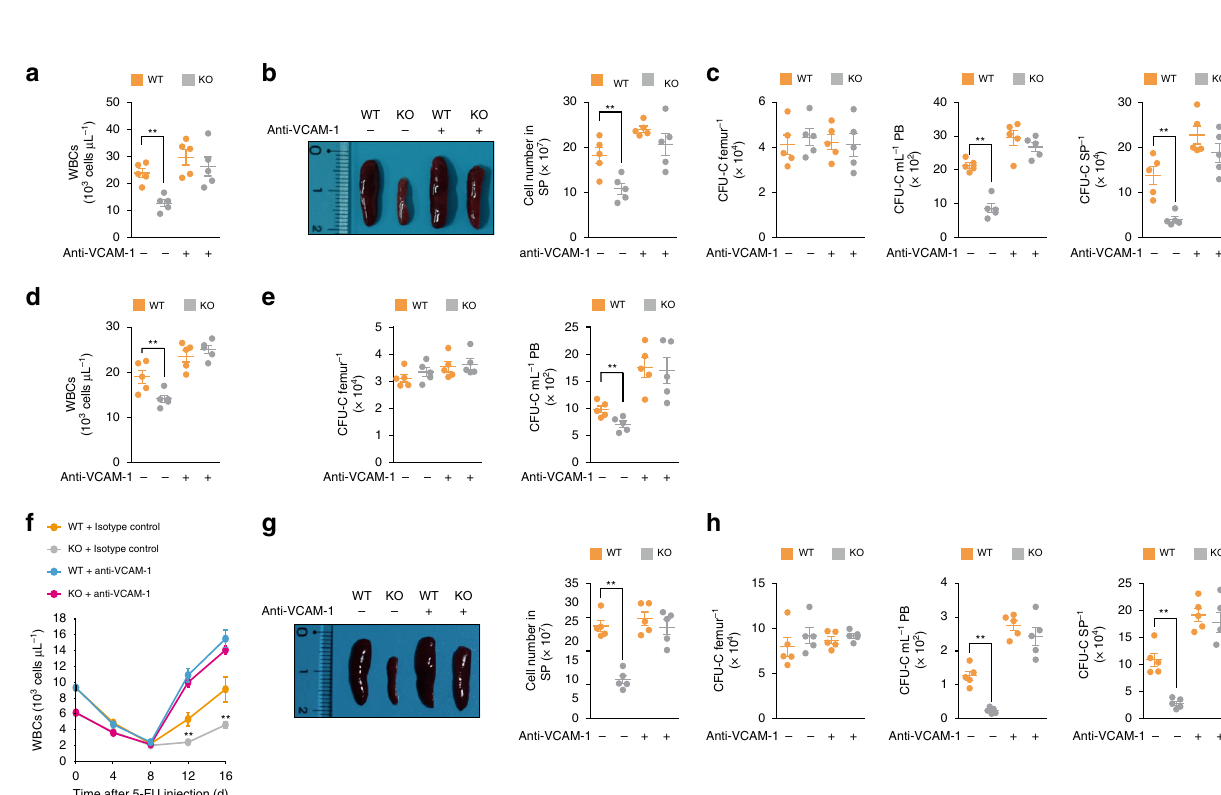
Fig. 8 Neutralizing interaction between VCAM-1 and VLA-4 reverses the defect involving regimen-induced HSPC mobilization in KO mice. a – c G-CSF- induced HSPC mobilization assays with anti-VCAM-1 Ab. n = 5 per group. a WBC counts from experimental animals until day 5 after G-CSF and Ab treatment. b Representative image of spleens (left) and absolute number of splenocytes from experimental animals on day 5 after G-CSF and Ab treatment (right). c CFU-C in the BM (femur), PB, and spleen (SP) from experimental animals on day 5 after G-CSF and Ab treatment. d , e WBC counts ( d ) and CFU- C ( e ) in PB from experimental animals 3 h after AMD3100 and Ab treatment. n = 5 per group. f – h 5-FU-induced HSPC cell mobilization assays with anti- VCAM-1 Ab. n = 5 per group. f Comparison of WBC counts between WT and KO mice at indicated time points after 5-FU and Ab treatment. g Representative image of spleen from a WT and KO mouse (left) and absolute number of splenocytes (right) of WT and KO mice on day 16 after 5-FU and Ab treatment. h CFU-C in the BM (femur), PB, and spleen (SP) of WT and KO mice on day 16 after 5-FU and Ab treatment. “ − “ , treatment with an isotype control Ab; “ + “ , treatment with anti-VCAM-1 Ab. Statistical signi fi cance was assessed by two-tailed Student ’ s t -test. ** P < 0.01. All data are presented